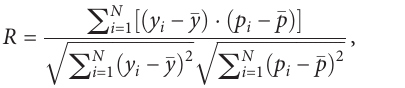
TABLE 1 | Patient characteristics of the two